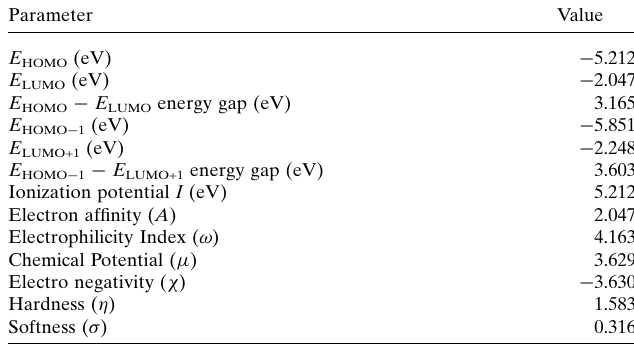
Table 2 Physico-chemical properties.